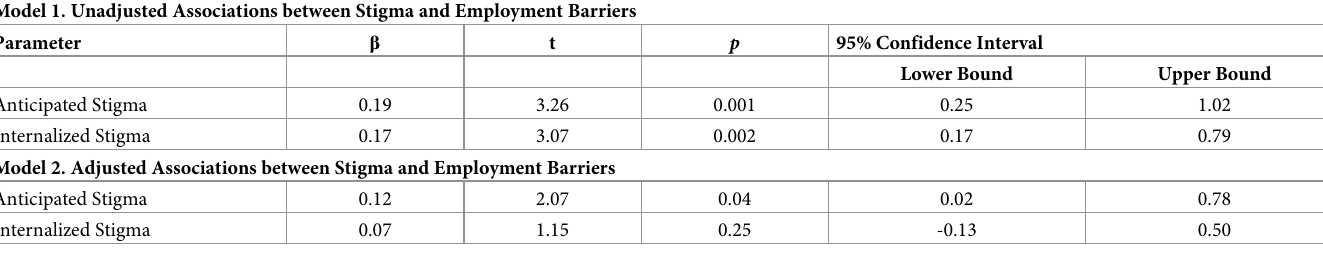
Model 2. Adjusted Associations between Stigma and Employment